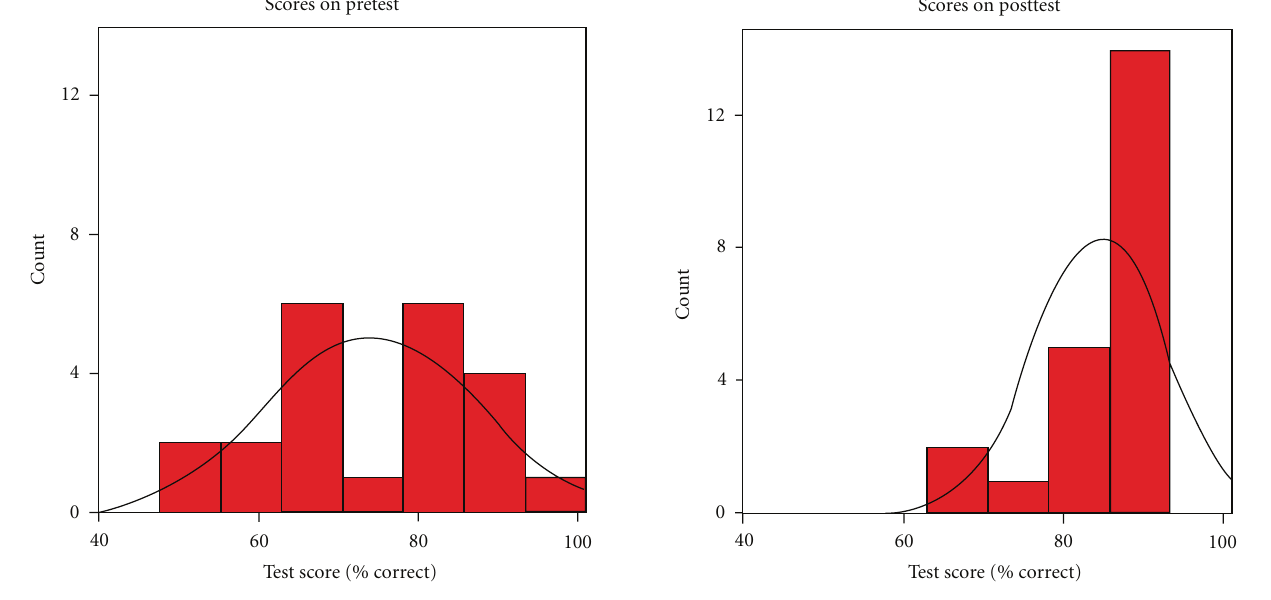
Figure 1: Pretest scores histogram. Figure 2: Posttest